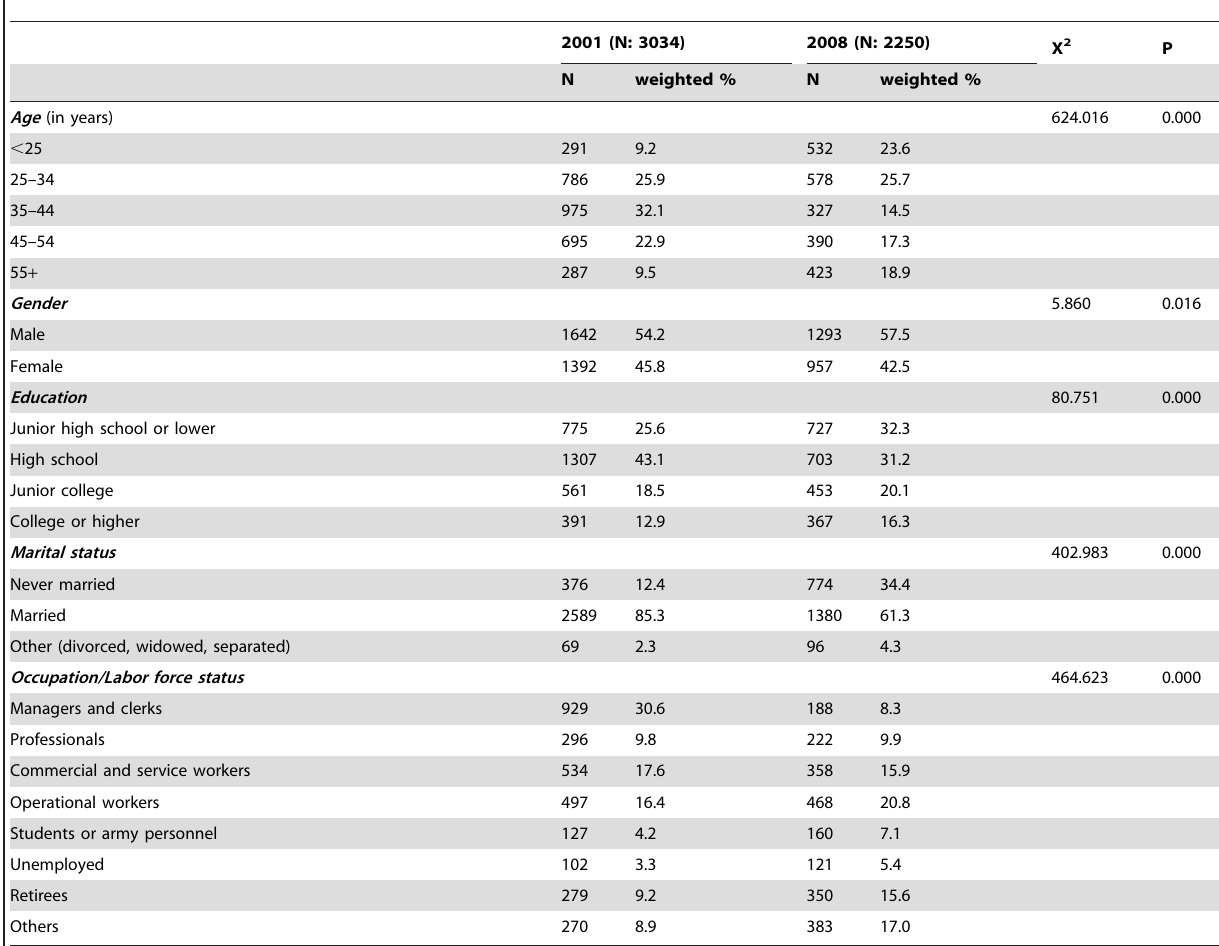
Table 1. Demographic characteristics of survey samples, 2001 and